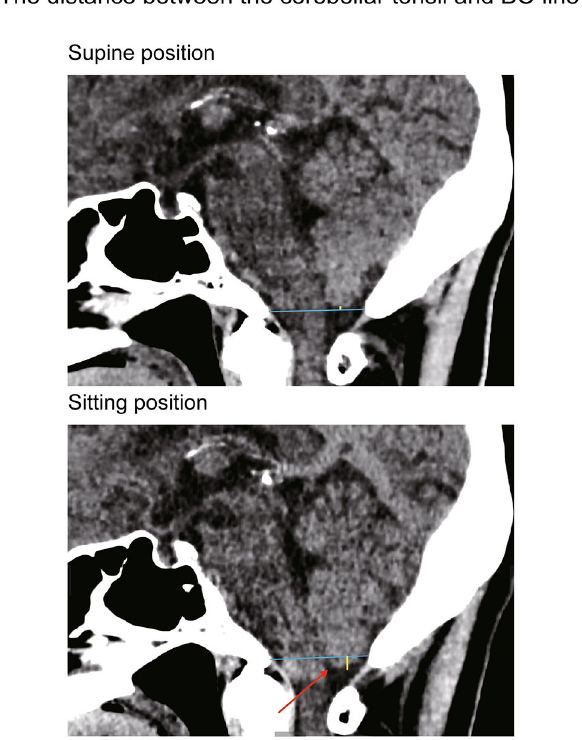
Figure 3. The distance between the cerebellar tonsil and BO line in supine (upper image) and sitting position (under image). The distance between the cerebellar tonsil and BO line shows yellow line, and BO line shows the blue line in picture. The tip of cerebellar tonsil was descended in sitting position (red arrow in sitting position).